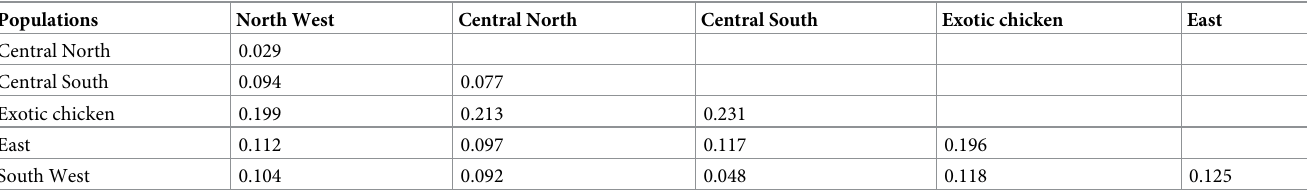
The extent of genetic distinction among the population with regard to allele frequencies (F ST ) and gene flow (Nm) are presented in Table 7. The results revealed a low genetic differentiation and a high gene flow between CN and NW, and likewise between SW and CS. A relatively high gene differentiation, however, was found between the E population and other